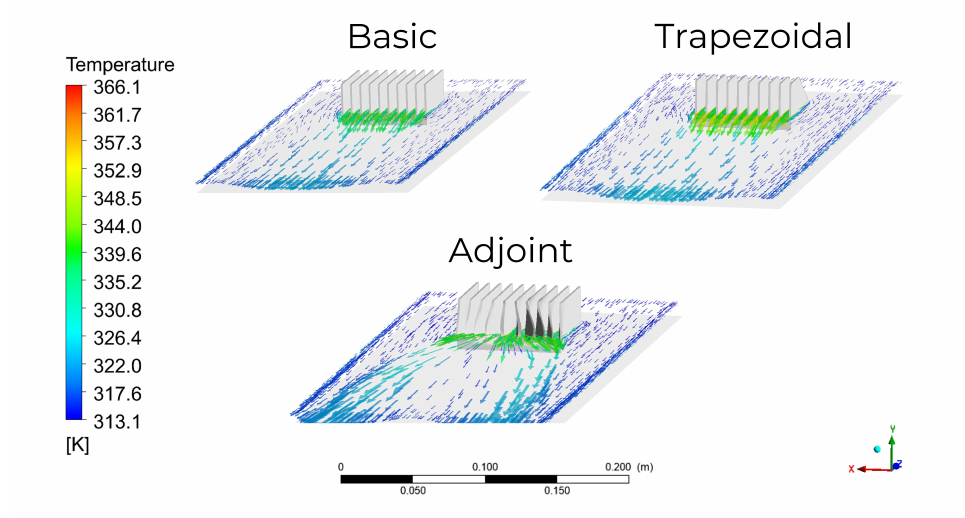
Figure 28. Comparison of flow direction and temperature field for three geometric models of a heat